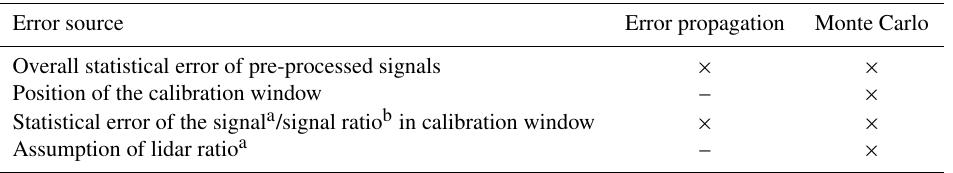
Table 1. Overview on error sources which are included in the calculation of uncertainties with error propagation or with Monte Carlo method. Error propagation is not implemented for Klett–Fernald and not recommended for iterative method. Error source Error propagation Monte Carlo Overall statistical error of pre-processed signals × × Position of the calibration window – × Statistical error of the signal a /signal ratio b in calibration window × × Assumption of lidar ratio a – ×